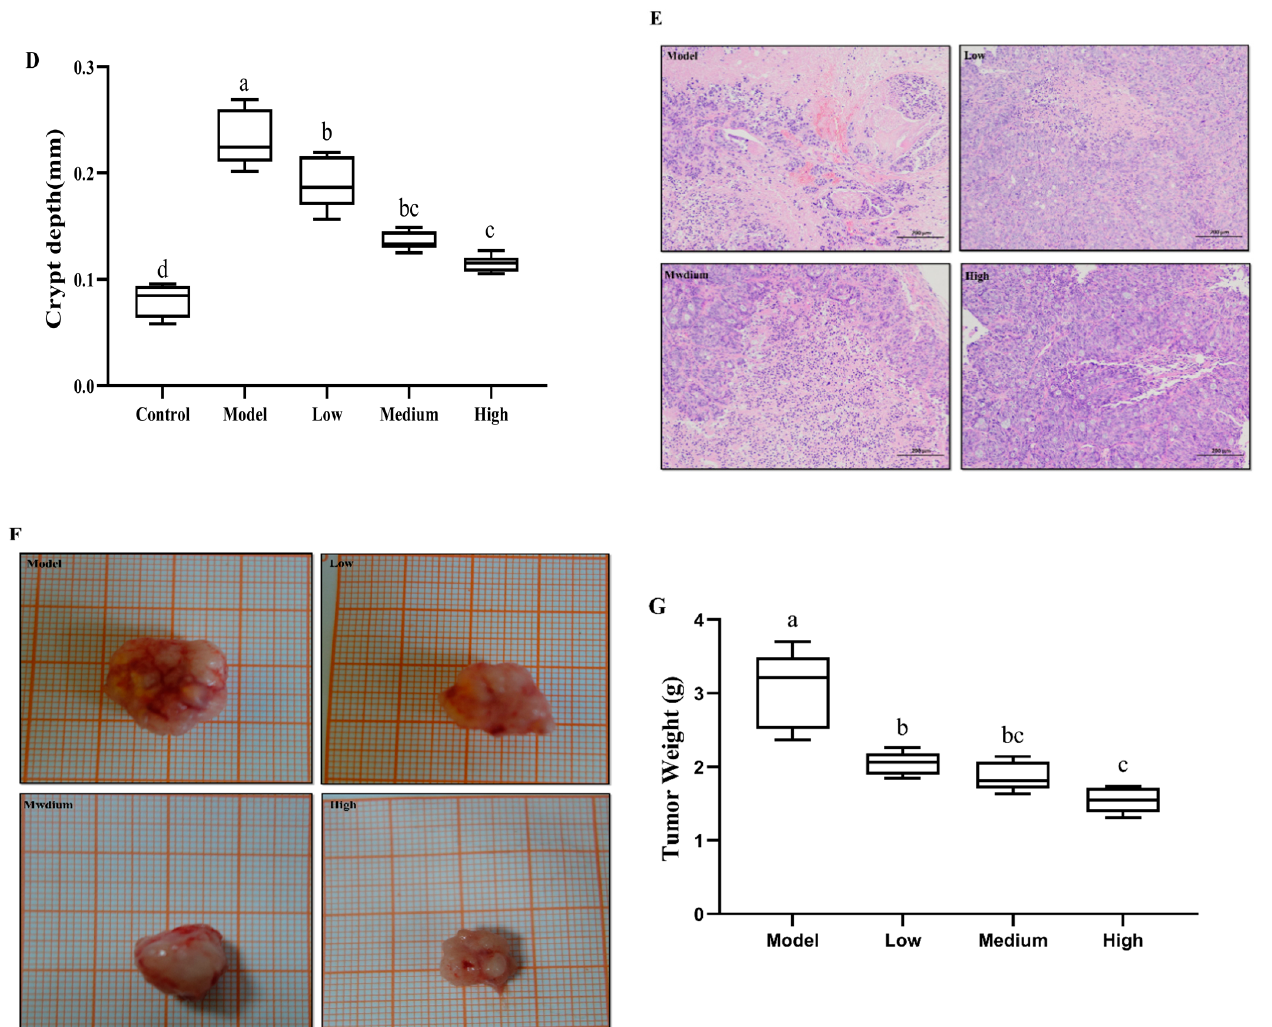
Figure 4. Effect of SCS on tumor in HT-29 xenograft tumor mice model. ( A ) Survival curve; ( B ) Effects on tissues and organs of mice in each group ( × 100); ( C ) Typical diagrams of HE stained cells in colorectal epithelial tissues with SCS ( × 100); ( D ) Effects of SCS treatment on the crypt height in colorectal epithelial tissues; ( E ) HE staining of tumor tissue ( × 100); ( F ) Representation images of tumors from each group; ( G ) Final tumor volume. During the 7-week experiment, the tumor volume of each animal was measured every week and the final tumor volume was measured after sacrifice, all results are expressed as mean ± SD ( n = 3). Different superscript letters for each column indicate significant differences ( p < 0.05) as compared to every other group.